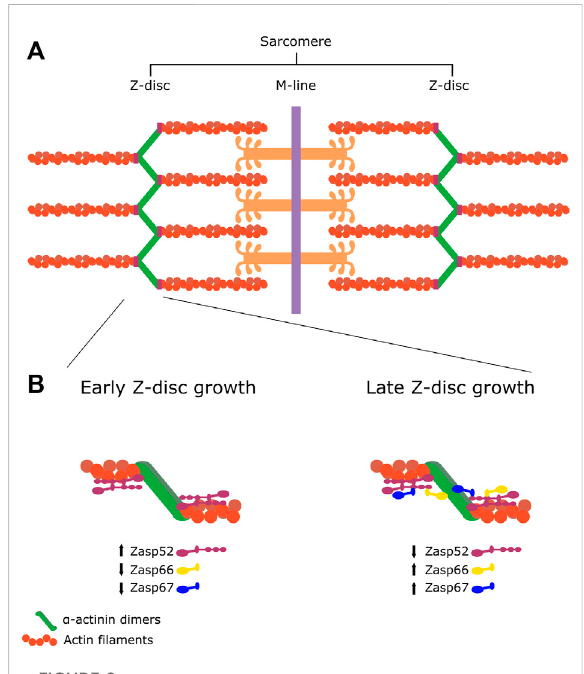
FIGURE 2 The sarcomere and Zasp52 during Z-disc growth (A) Structure of the sarcomere. The myosin thick fi laments are linked at the M-line, and the actin thin fi laments are anchored at the Z-disc. (B) Process uncovered by González-Morales et al. (2019b). During early Z-disc growth, the “ growing ” isoform (Zasp52) predominates and allows interaction with other Zasp proteins through the ZM/LIM interaction. During late Z-disc growth,the “ blocking ” isoformswithnoLIMdomainspredominate (Zasp66 and Zasp67), which inhibits further growth of the